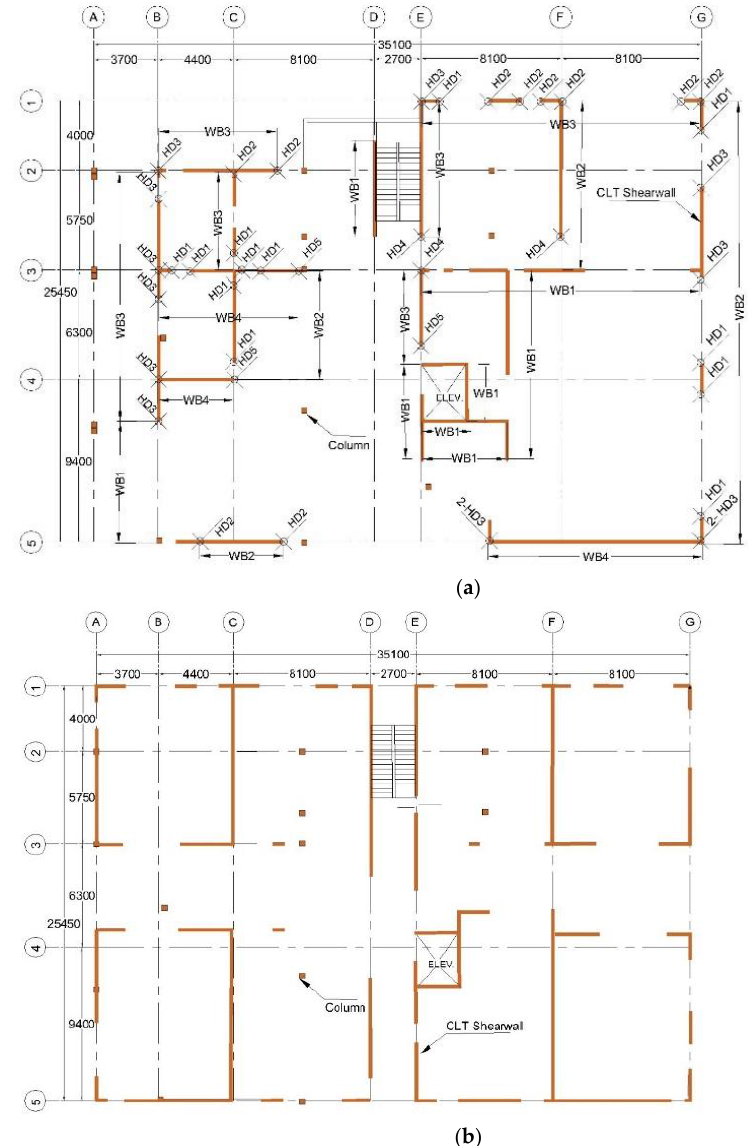
Figure 2. Plan view of northern block of building: ( a ) first floor, and ( b ) second floor (unit: mm).